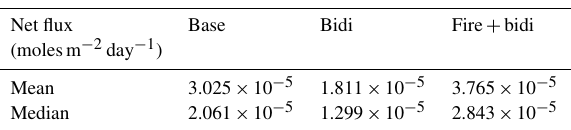
Table 4. Average NH x deposition (downward flux) over the Alberta and Saskatchewan model domain during 12 August to 7